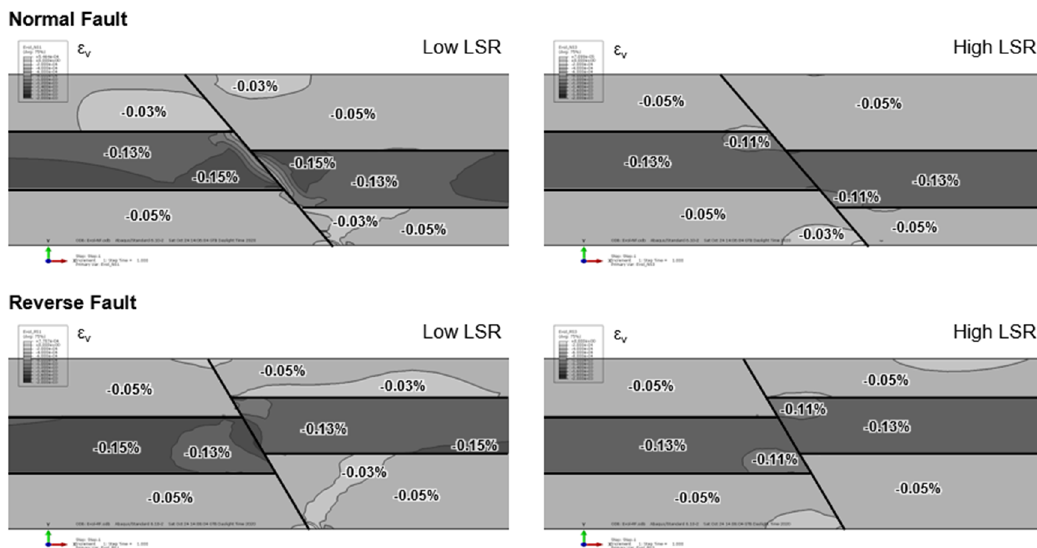
Figure 14. Contours of the volumetric strain at low and high LSR scenarios for the normal fault (upper) and reverse fault (lower) geometries. The range in the legends is −0.2–0%.